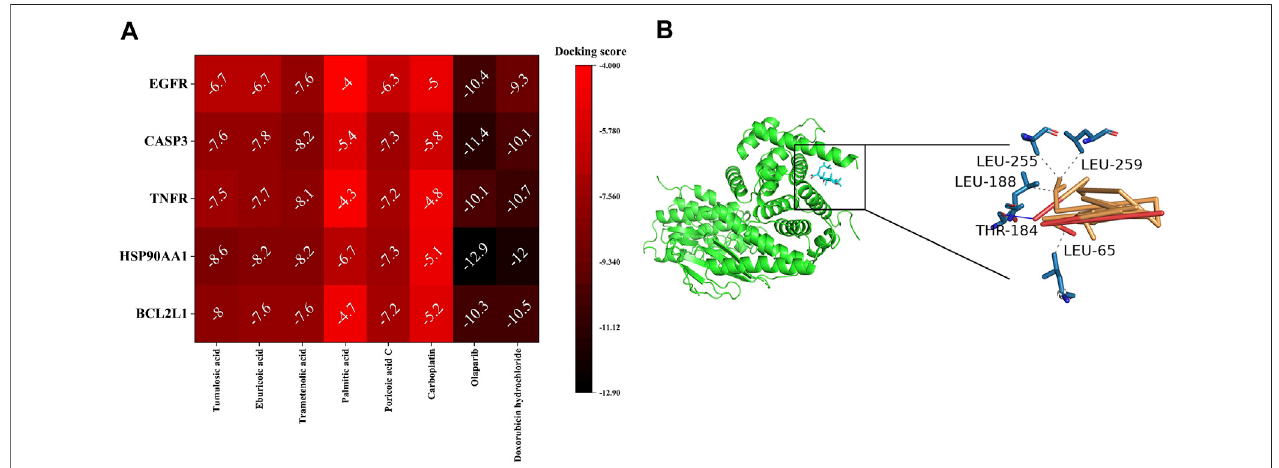
FIGURE 8 | Ingredient-target molecular docking. (A) The docking score of Ingredient-target. (B) The docking diagram of tumulosic acid-BCL2L1. Dashed lines represent hydrogen bonds.